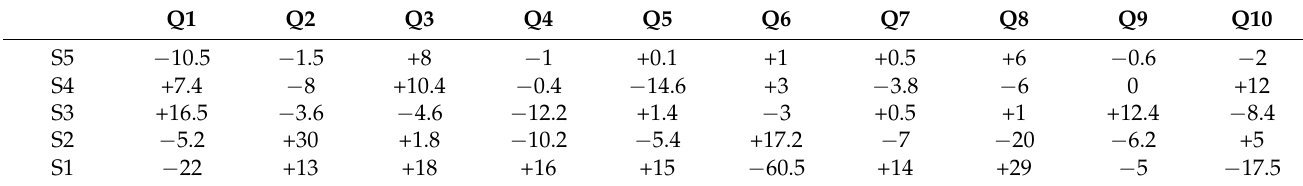
Figure 7. Attention weights after using performance bias function. Table 9. The difference between student performance and average